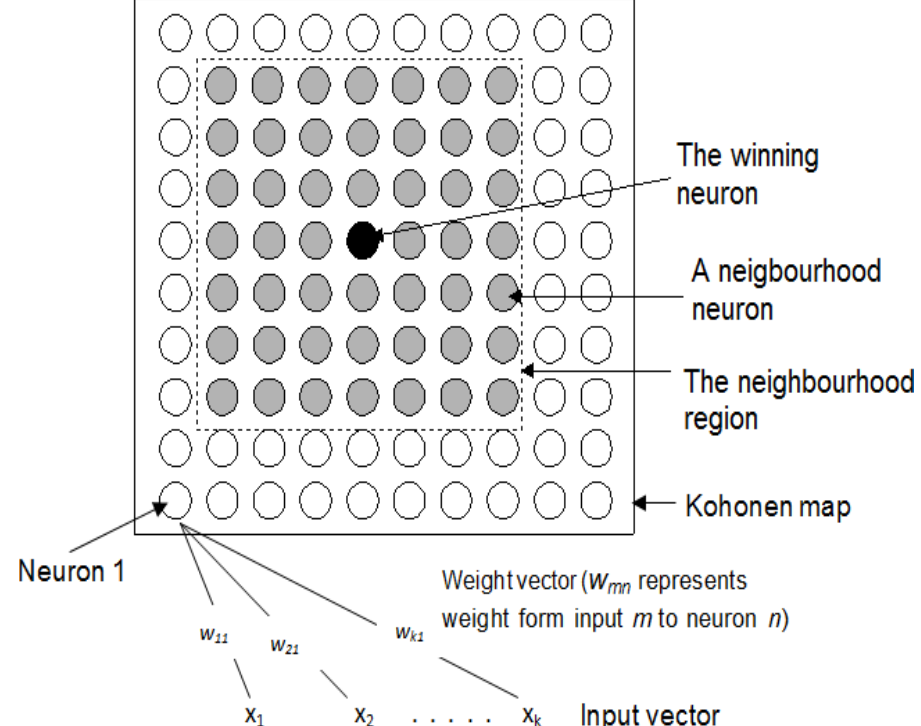
Figure 1. Kohonen neural network with a 10 × 10 output (Kohonen) map.